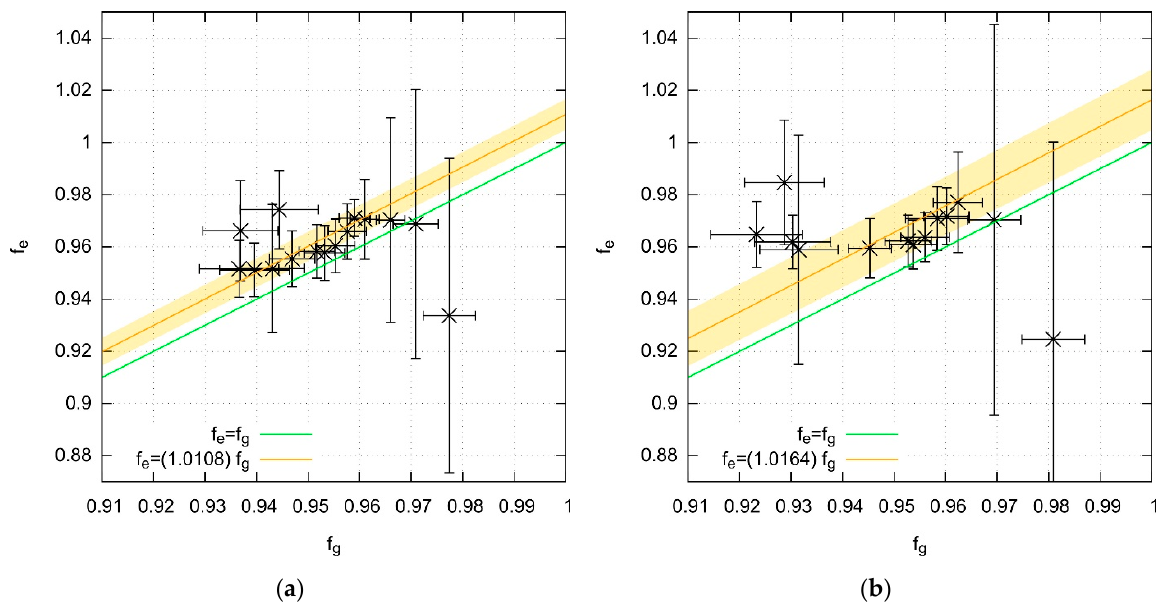
Figure 6. Correlation between the vibrational frequency scaling factors obtained for the ground electronic states, f g , and for the excited states, f e . Orange line represents the best fit of the f e = slope × f g function. Yellow strap marks the 3 σ confidence interval (the green line corresponding to slope = 1 falls out of 3 σ ). Computations were performed with all functionals listed in Tables 4 and 5 and with the aug-cc-pVTZ basis set. ( a ) Reference data taken from gas-phase measurements; the uncertainty of slope value is 0.0019. ( b ) Reference data taken from Kr-matrix measurements; the uncertainty of slope value is 0.004.